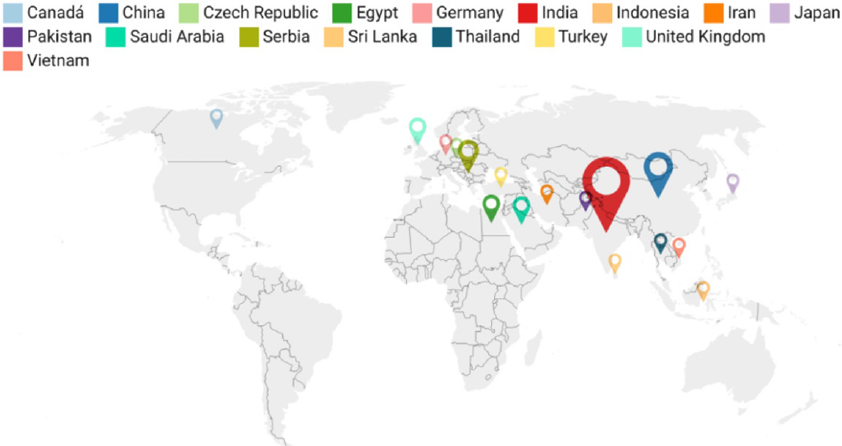
Figure 4. World map showing the countries where the Streptomyces strains were isolated.